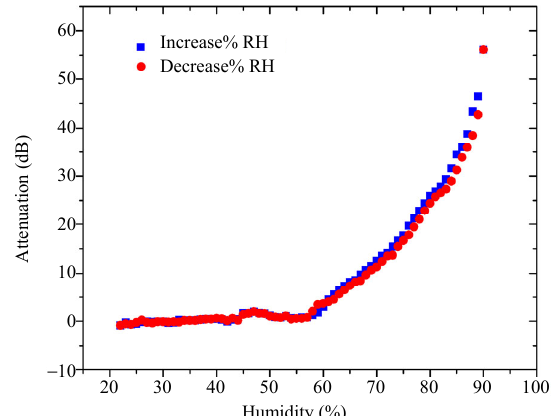
Fig. 5 Response to humidity occurrs in the range of 56% RH to 90%